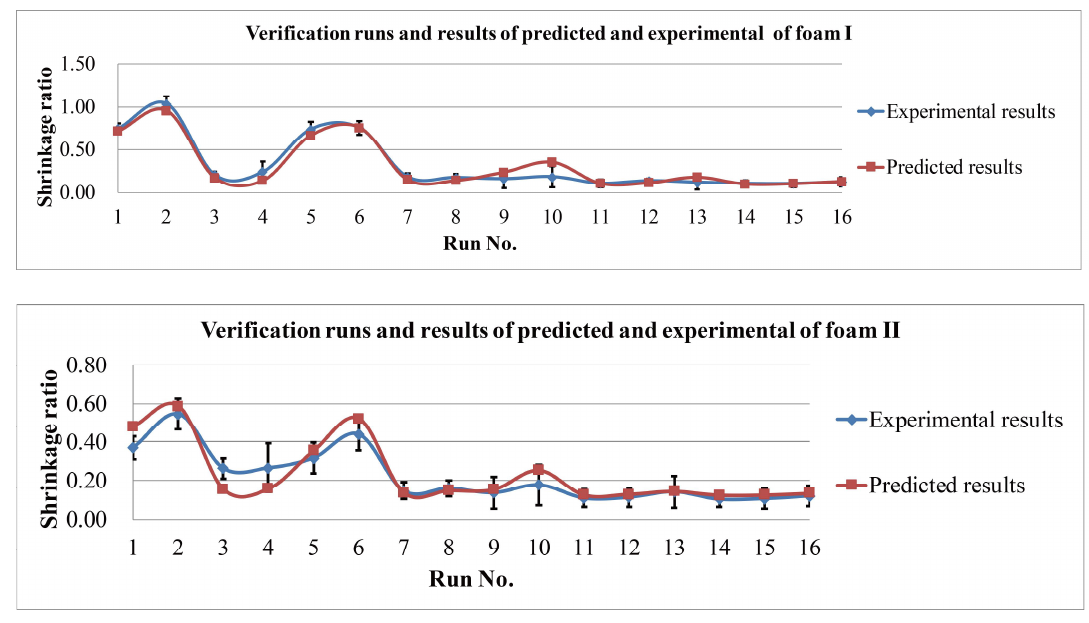
Figure 5. Simulation and experimental results of Foams I and II.